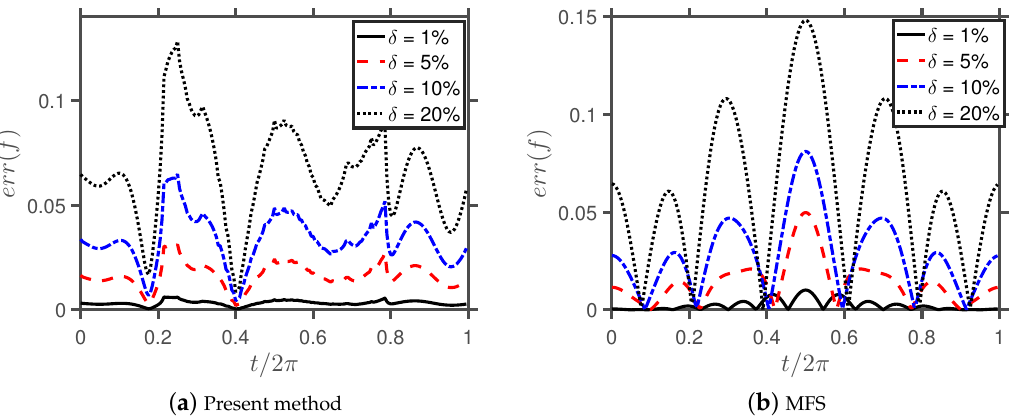
Figure 7. The relative errors of f obtained with various amounts of noise added in the boundary data on ∂ D